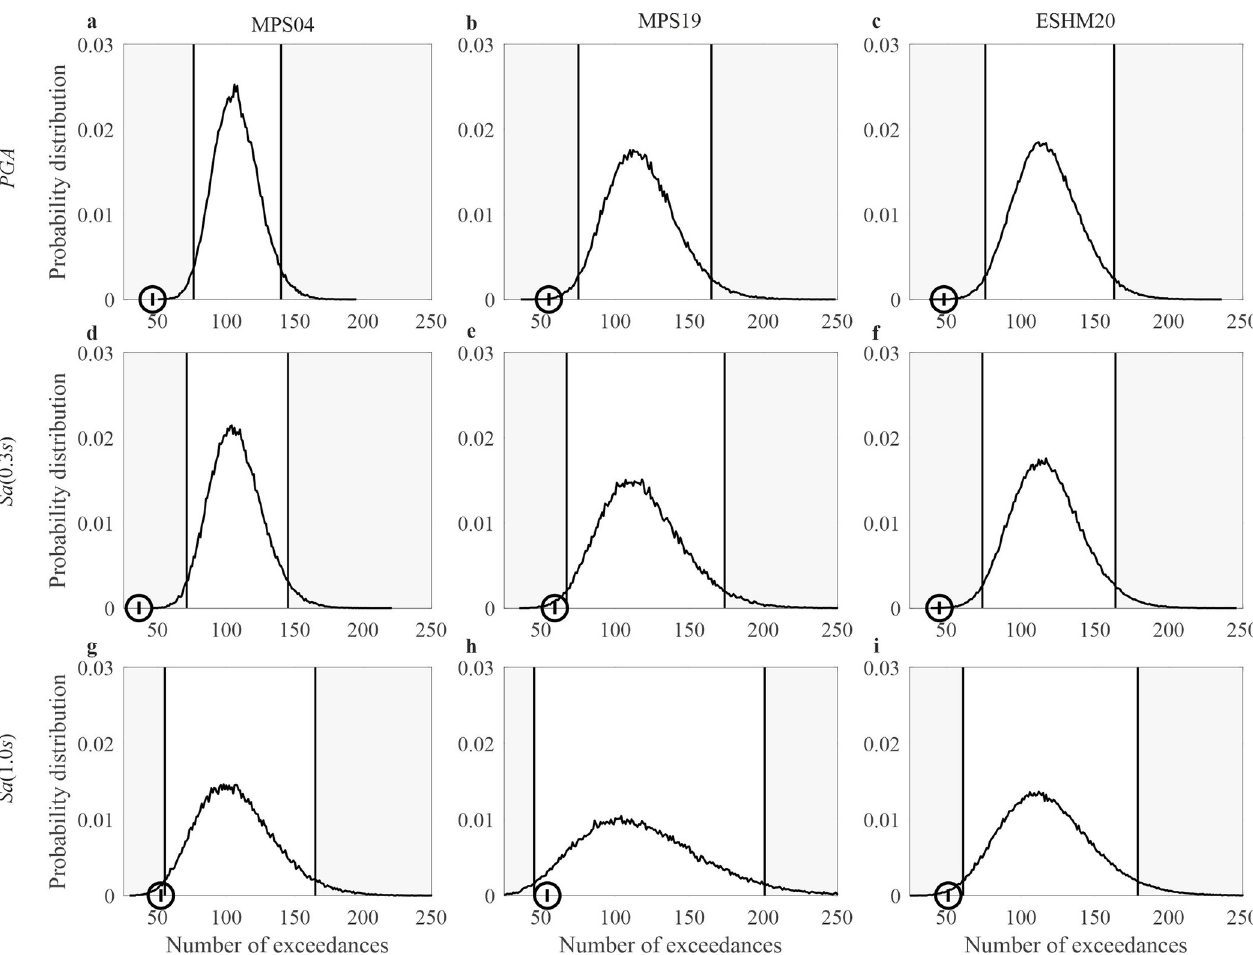
Fig 5. Results of the tests for T = 50 yr . Distribution of the total number of exceedances from 1973 to 2019 of the ground motion intensity with T r 143 sites where continuously recording stations have been present, each in a time period, and total observed exceedances at the same stations. The panels in the same columns refer to the same model: (a), (d), (g) are from MPS04; (b), (e), (h) are from MPS19; (c), (f), (i) are from ESHM20. The panels in the same row refer to the same IM : (a), (b), (c) are PGA ; (d), (e), (f) are Sa (0.3 s ) ; (g), (h), (i) are Sa (1.0 s )